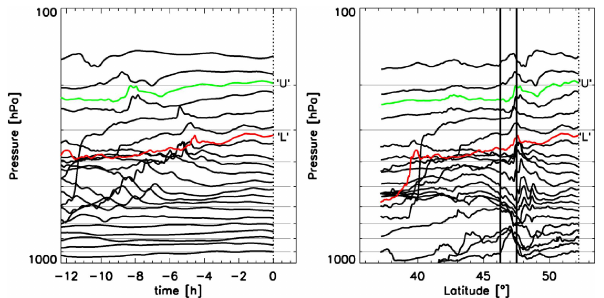
Figure A2. Field of COSMO-7-based LAGRANTO trajectories highlighting the two 2 Fig. A2. Field of COSMO-7-based LAGRANTO trajectories high- trajectories ending in the lower cloud ‘L’ (red) and upper cloud ‘U’ (green). Left panel: 3 lighting the two trajectories ending in the lower cloud “L” (red) and trajectory pressure vs. time. Right panel: trajectory pressure vs. latitude. Waves are caused 4 upper cloud “U” (green). Left panel: trajectory pressure vs. time. by the main chain of the Alps located around 47°N (indicated by vertical lines). 5 Right panel: trajectory pressure vs. latitude. Waves are caused by the main chain of the Alps located around 47 ◦ N (indicated by ver- tical